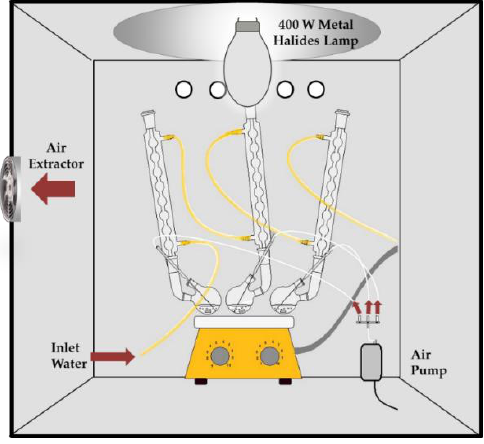
Figure 3. Scheme of the photocatalytic reactor.